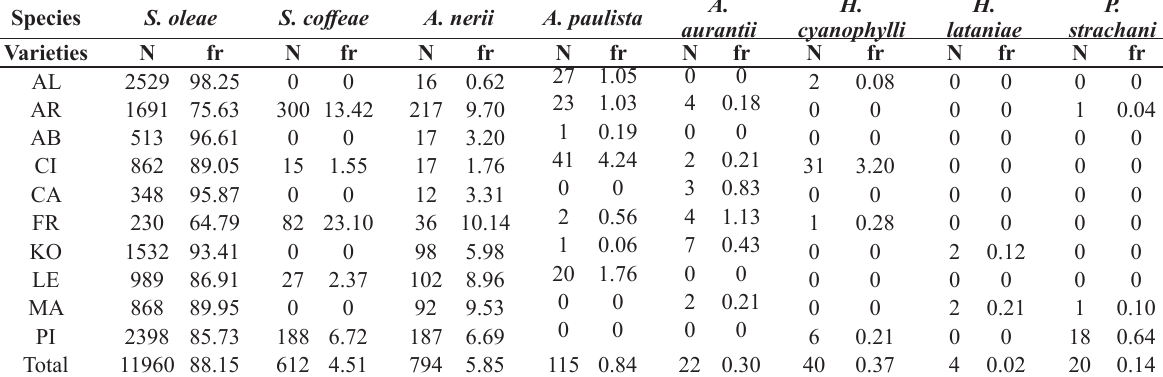
Number of individuals (N) and relative frequency (%) (fr) of scale insect species found in ten varieties of olive trees (